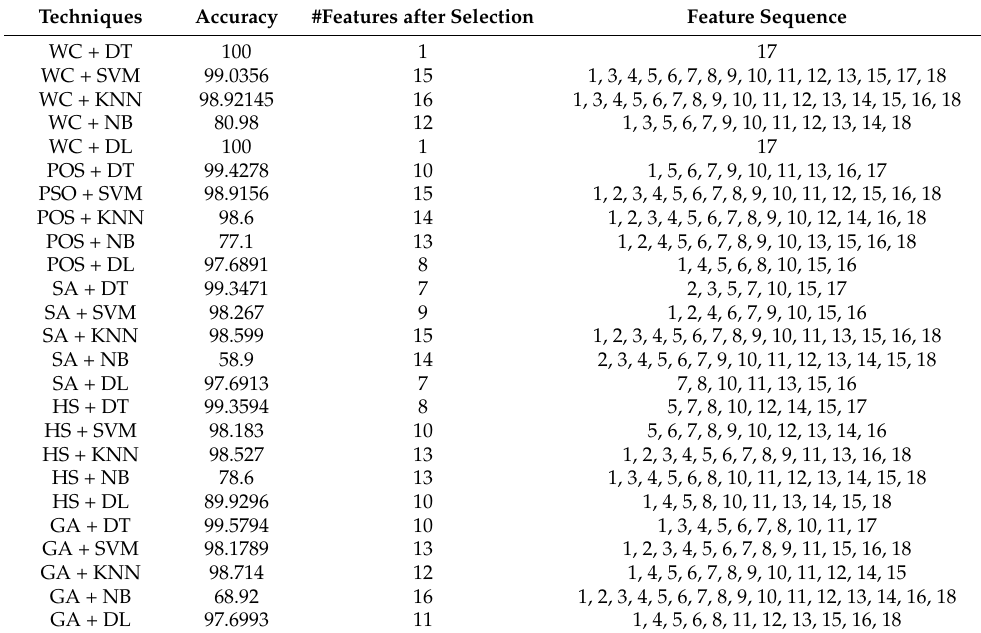
Table 7. Results of five classifier algorithms using various feature selection techniques.